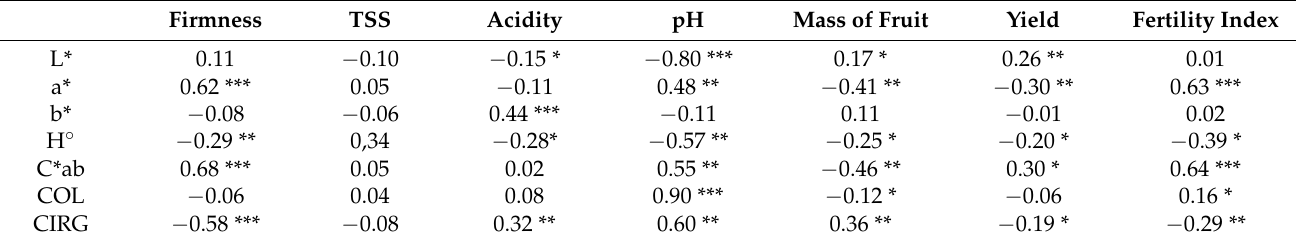
Table 11. Correlation coefficient between fruit coloring and fruit quality